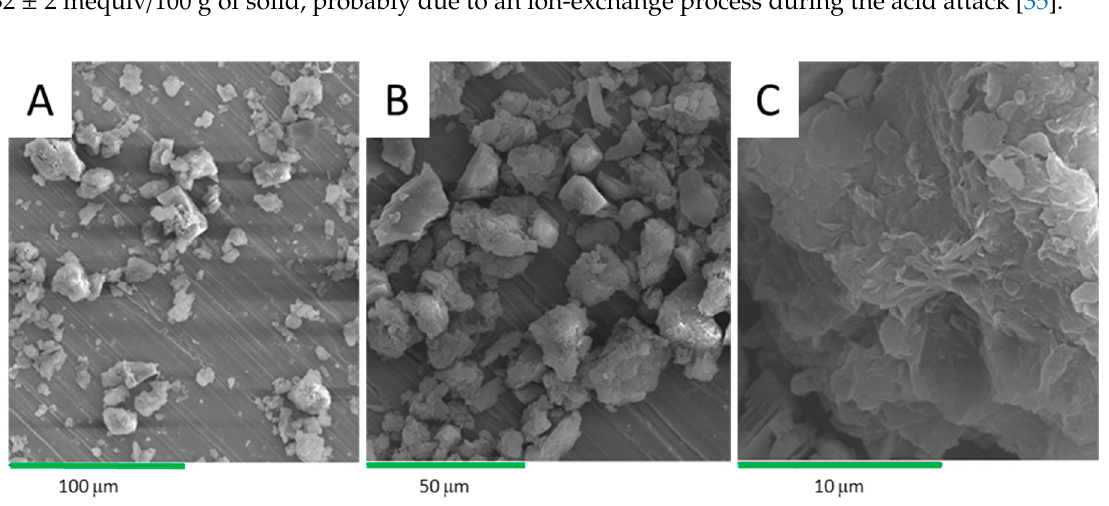
Figure 8. SEM micrographs at several magnifications of the 1 h acid-activated clay (AC).